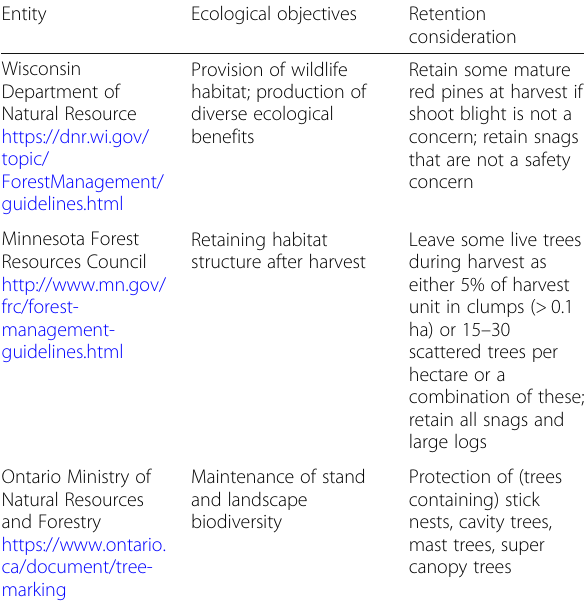
Table 1 Examples of organizations and agencies that recommend some form of retention in their red pine management guides